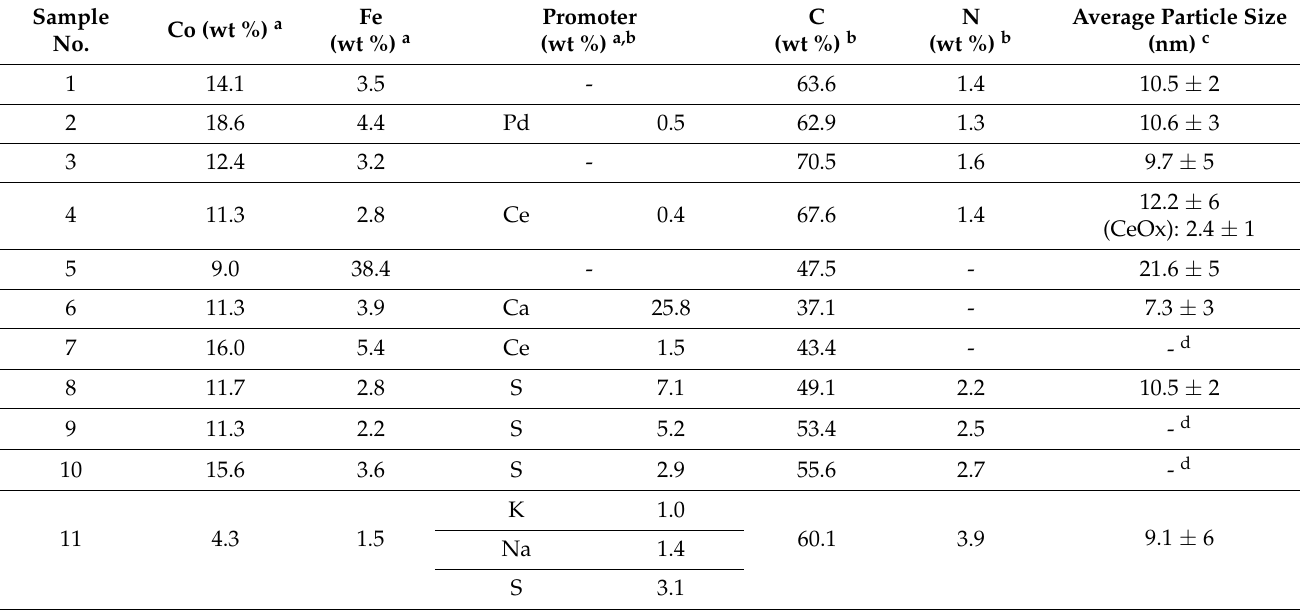
Table 1. List of samples under study and their main analytical and physicochemical